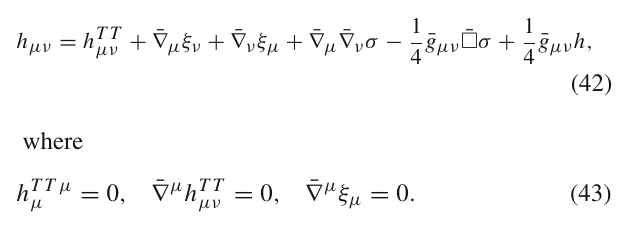
These diagrams consist of four vertices and all of them